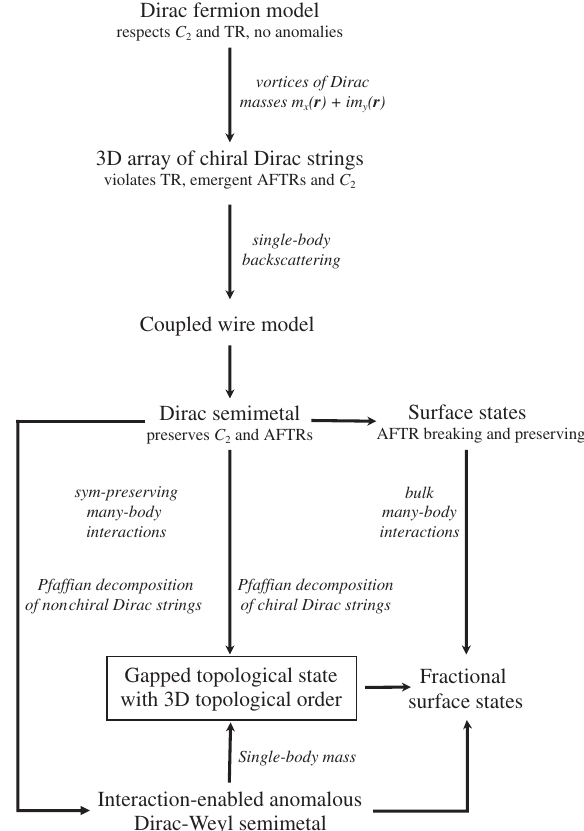
FIG. 2. Logical outline of the paper. It shows the procedure of going from a Dirac fermion model to an interaction-enabled gapped state with three-dimensional topological order. Here, C 2 is the twofold (screw) rotation symmetry, TR is time-reversal symmetry and AFTR is the antiferromagnetic time-reversal symmetry.